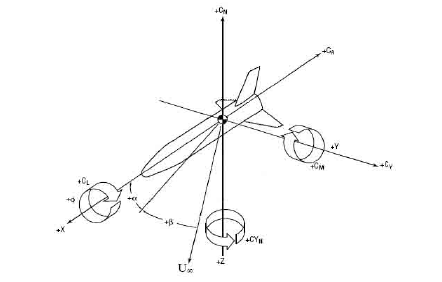
Fig.9 aerodynamic axis